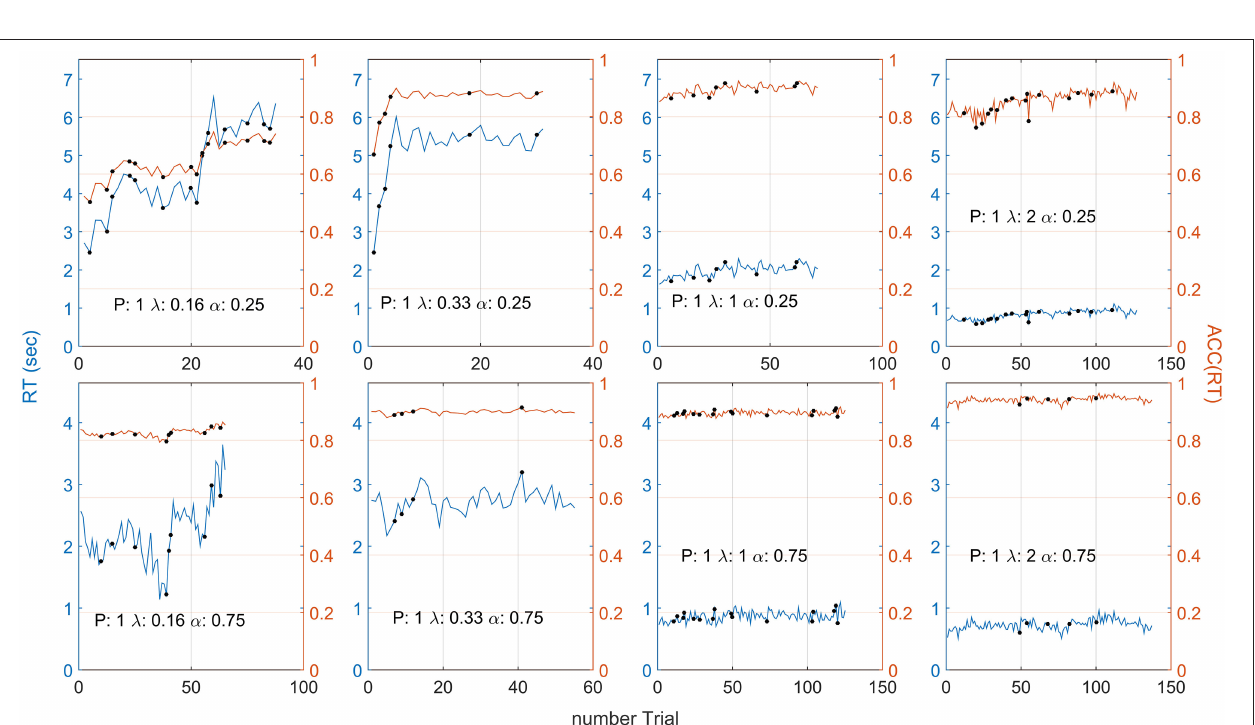
FIGURE 4 | Participant 1 responses in terms of RT (blue lines) and ACC ( RT ) (orange lines) for each λ and α condition. The black dot indicates that a punishment has been given on that trial. On average, ACC ( RT ) increases with λ and is usually lower for the α depended on the condition (which always lasted 3 minutes). For example, when α less trials were made. Note that high variability in RT does not always correspond to high variability in ACC ( RT ) . Compare this plot with Figures 5A,B , for the grouped RT and ACC ( RT ) across participants. Note that the two α conditions have two different scales.